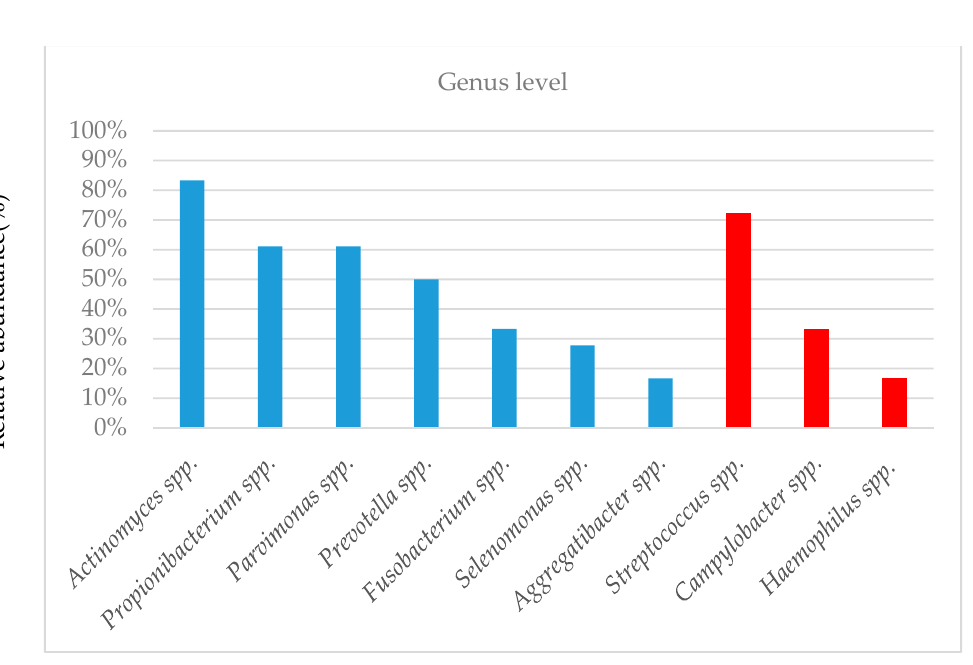
Figure 2. Top 10 bacterial species with the most frequent appearance. The most common combinations were Actinomyces spp. and Streptococcus spp. in 10 eyes, Parvinomonas spp. and Streptococcus in 10 eyes, followed by Actinomyces spp. and Parvinomonas spp., Actinomyces spp. and Prevotella spp., Actinomyces spp. and Propionibac- terium spp. (combination of two genera), and Actinomyces spp. and Parvinomonas spp. and Streptococcus spp. (combination of three genera), found in eight